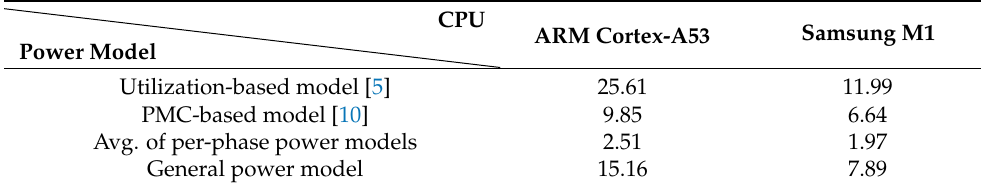
Table 5. Comparisons with existing CPU power models (unit: MAPE (%)).